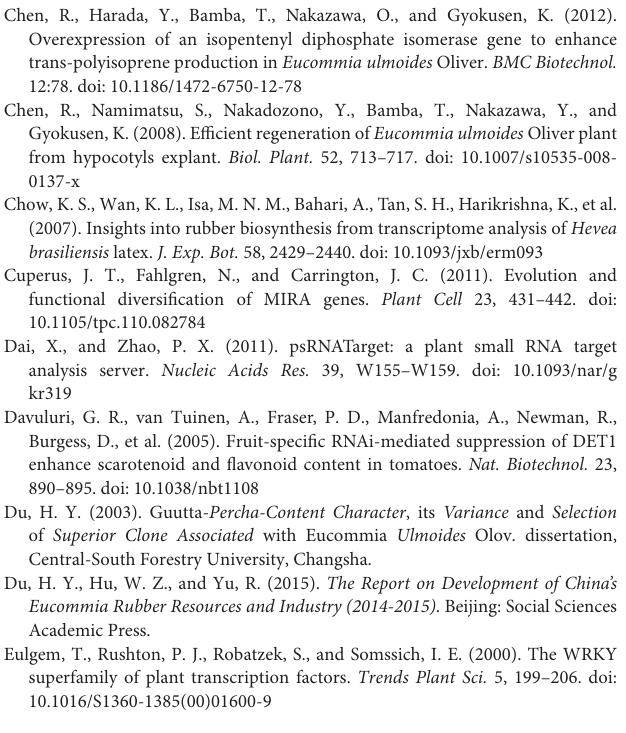
RPM, as indicated in the color key. Table S6 | Target prediction of miRNAs in Eucommia